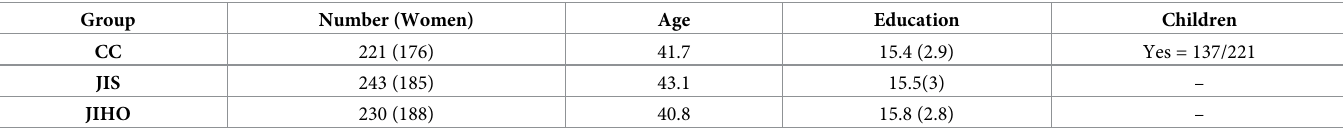
Table 1. Number of participants and age and education of participants in the three groups.